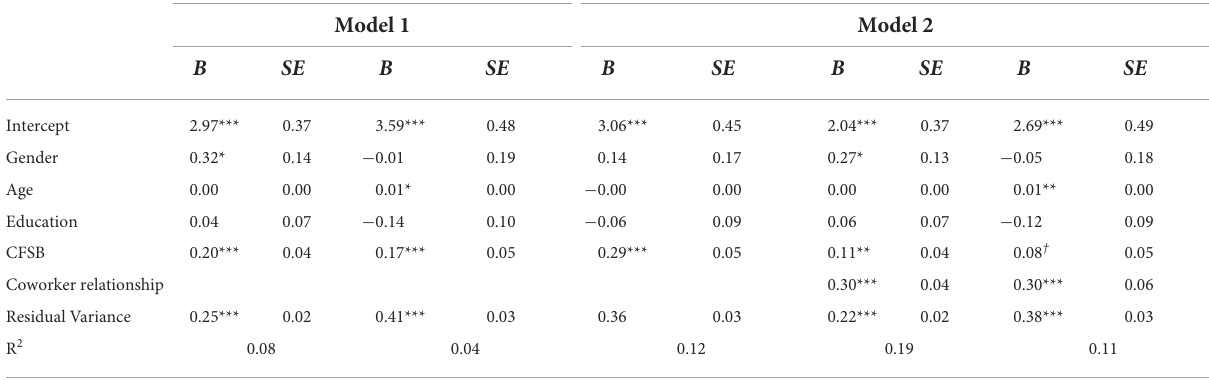
TABLE 3 Main effects and mediating effects (M1 and M2).